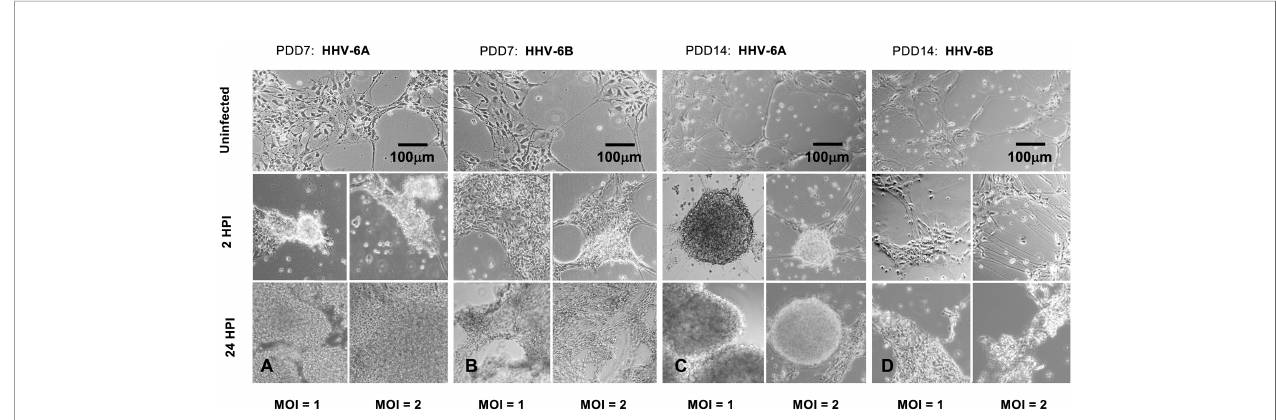
FIGURE 4 | Light microscopy of HHV6-induced cytopathic effects (CPEs) on dHNSC at PDD 7 and 14. (A) Uninfected cultures of HNSC at PDD7 show healthy cells adhering to the plate surface (top). After two hours post-infection (2HPI) at MOIs = 1, 2 (middle, left and right, respectively) with HHV-6A, cells begin to aggregate and at 24HPI with HHV-6A at MOIs = 1, 2 (bottom, left and right) there is highdensity clumping and cell detachment. (B) Uninfected cultures of HNSC at PDD7 show healthy cells adhering to the plate surface (top). After 2HPI with HHV-6B at MOIs = 1, 2 (middle, left and right), cells begin to aggregate and at 24HPI with HHV-6B at MOI = 1, 2 (bottom, left and right) there is higher-density aggregation. (C) At PDD14, uninfected healthy cells persist (top); however, at 2HPI at MOIs = 1,2 (middle, left and right) infection with HHV-6A results in highdensity cell aggregation and at 24HPI rampant cell death and detachment is observed (bottom, left and right). (D) At PDD14, uninfected cells persist (top); however, HHV-6B infection at MOIs = 1,2 for 2 HPI results in lower-density cell aggregation (middle, left and right) with higher-density clumping occurring at 24HPI (bottom, left and right). [Scale bar = 100